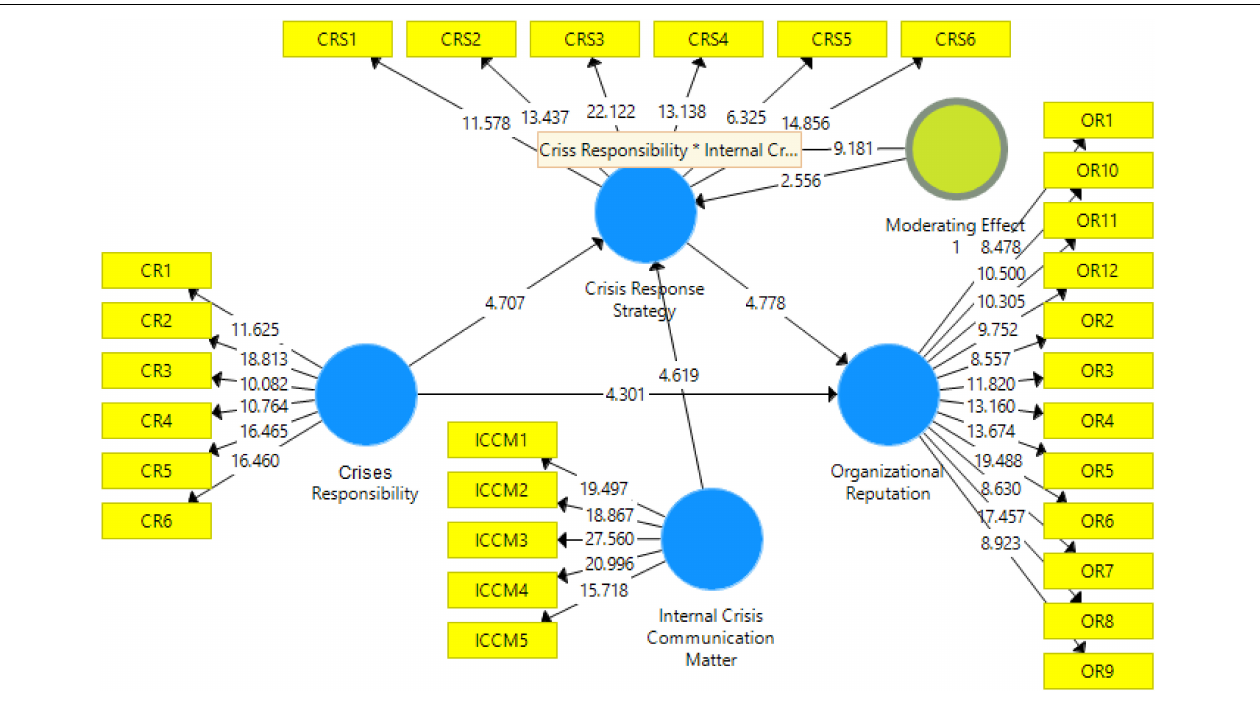
FIGURE 2 | Structural